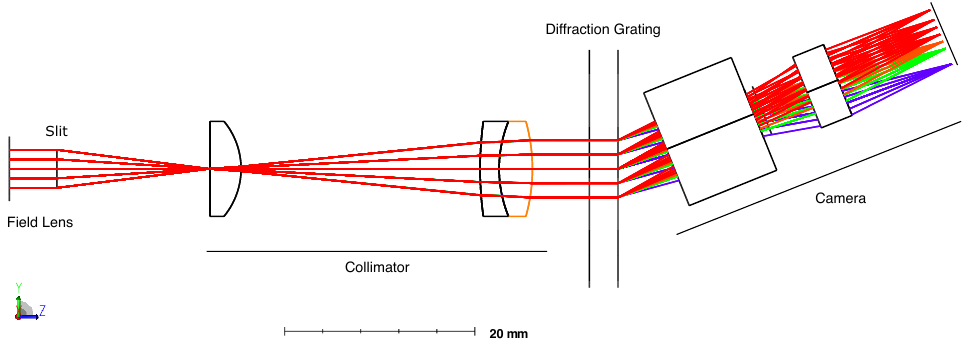
Figure 2. Spot diagrams: ( a ) Sigernes et al. [21] original design, and ( b ) our optimised optical design used by OpenHSI. The key improvement is a more uniform focus across the spectral range, which translates to a more uniform spatial contrast when comparing spectral channels in the hyperspec- tral image.